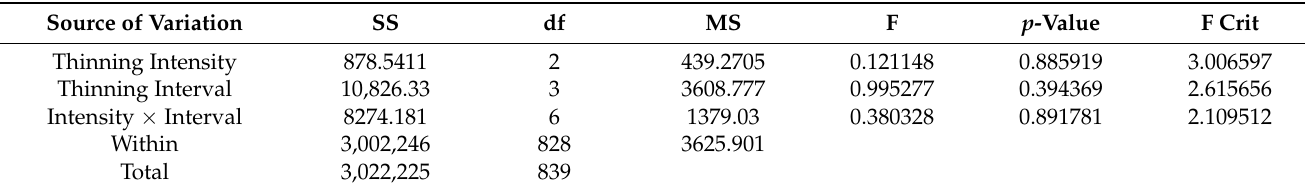
Table A4. Two-way ANOVA test for accumulated biomass.